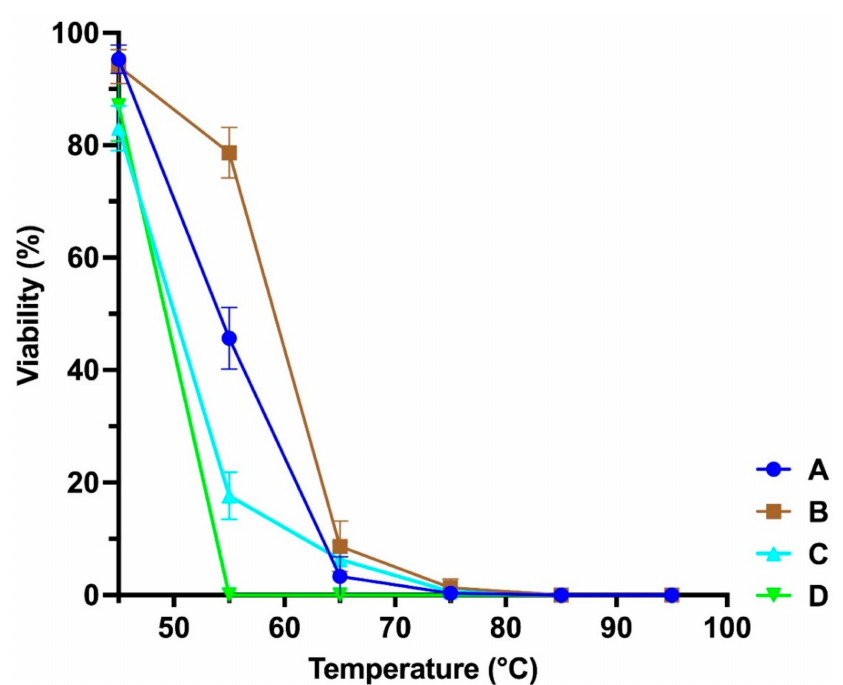
Figure 2. Thermal stability of bacteriophages: (A) Pseudomonas Phage_AUS260, (B) Pseudomonas